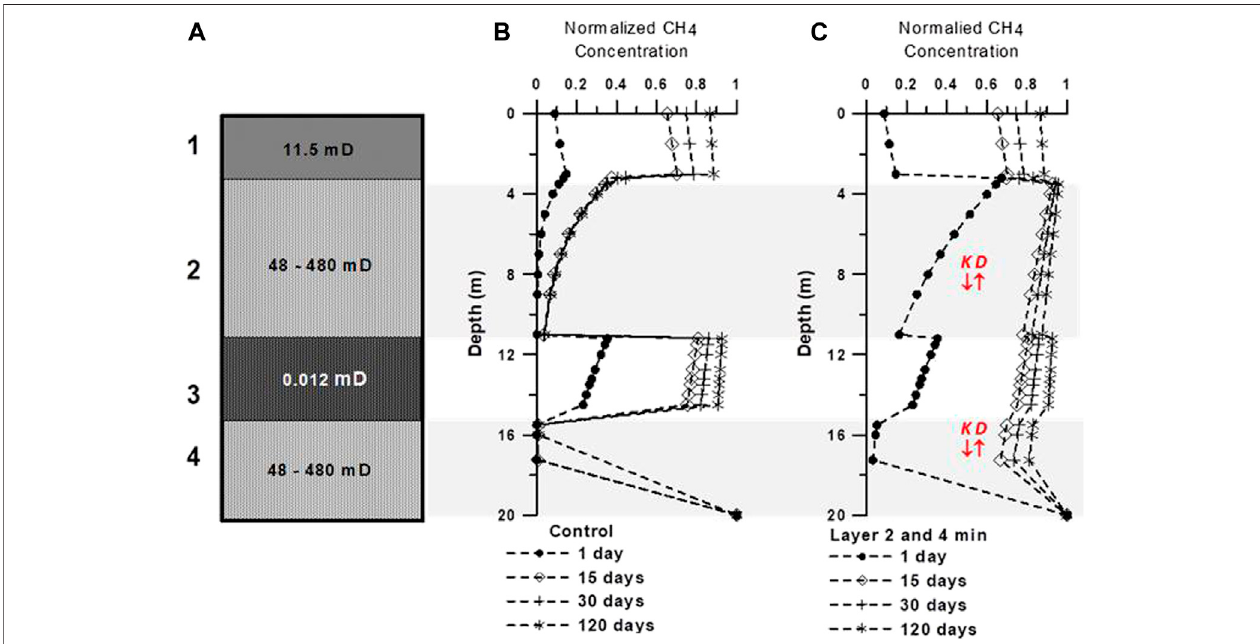
FIGURE 7 | Examples of sensitivity checks varying the permeability of a speci fi c lithology and its correlative U and Ds in borehole BH8. (A) Arrangement of sedimentary layers of the control sequence (i.e., maximum permeability and corresponding diffusion coef fi cients in all the layers), with the permeability values tested for the fi ne sands containing the upper aquifer (i.e., layer 2). Numerical results using (B) maximum 480 mD and (C) minimum 48 mD K values in layers 2 and 4 (and corresponding U and D s)for1,15,30and120 days.Thered arrowsbesidesthepro fi lesin (C) illustratetheincrease(arrowup)ordecrease (arrowdown)ofthe K s and D s, relative the pro fi les in (B) , according to the empirical D/K relationship of Figure 5 .